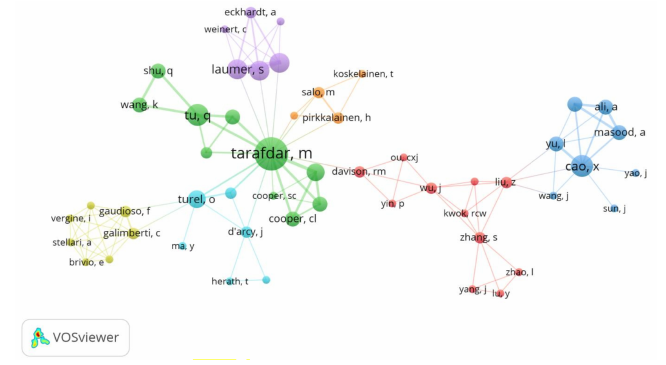
Figure 5. Researchers co-authorship